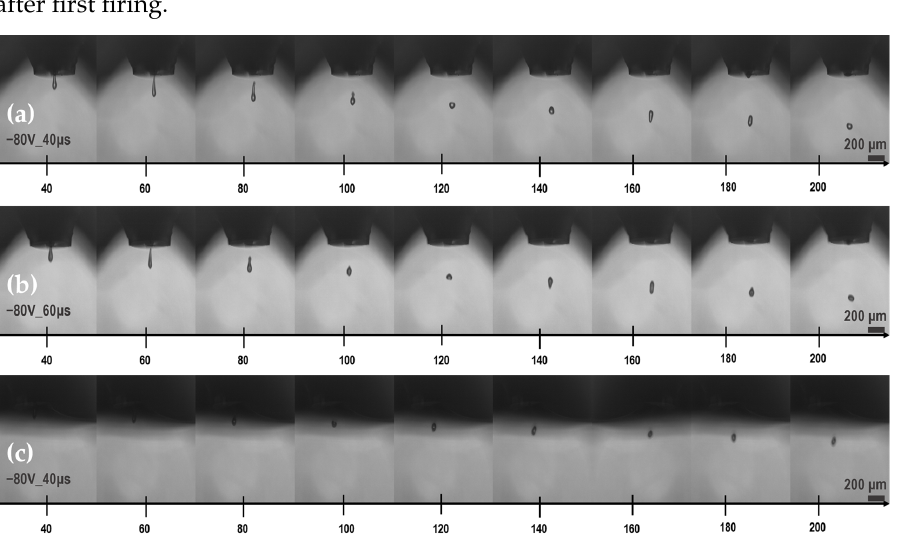
Table 1. Printing properties classified by ink concentration.